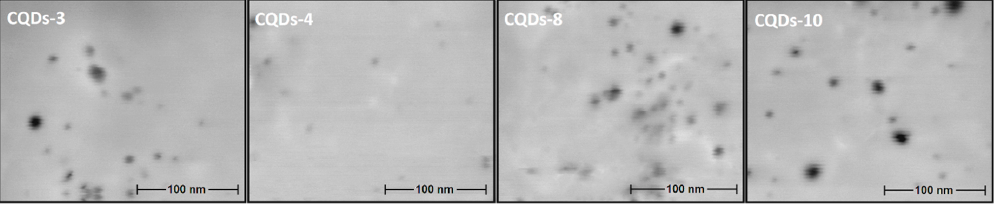
Figure 5. SEM microphotographs of the CQD-3, CQD-4, CQD-8 and CQD-10 samples.